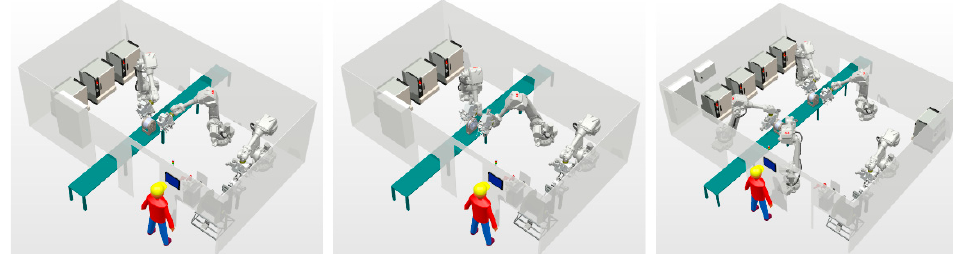
Figure 10. Graphical illustrations from simulations of the robotized stator cable winding with one smaller rotating electric machine designs S2a ( left ) and S2b ( middle ), and of the extended robot cell for winding two S2 machines simultaneously ( right ).